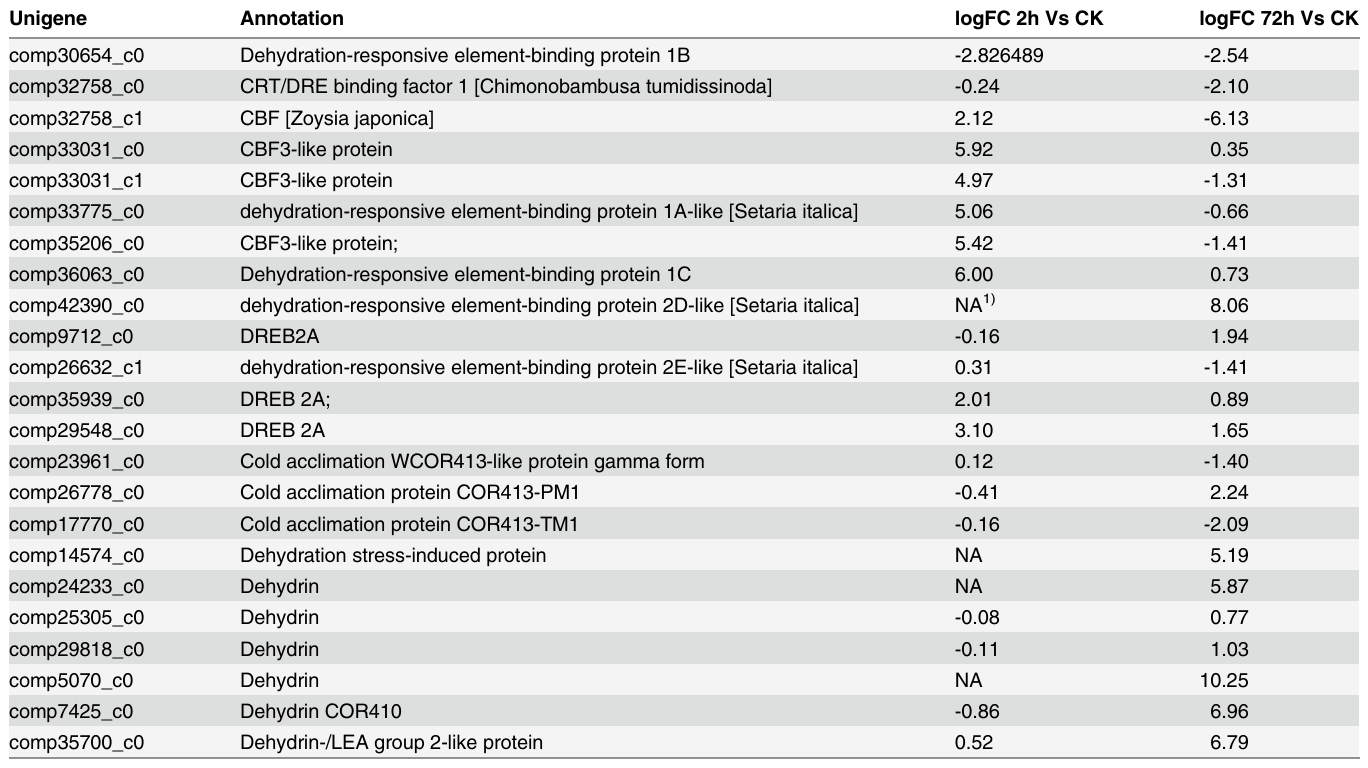
Table 5. Expression changes of unigenes of DREB1, DREB2 and COR/dehydrin. Unigene